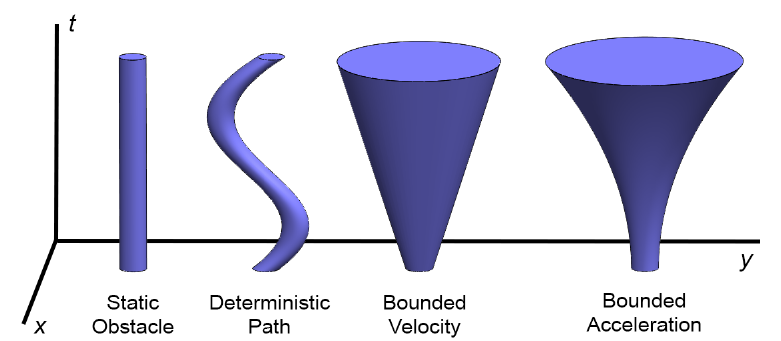
Figure 4. Obstacles as space-time volumes in (cid:60) 2 × Time space, adapted from [235]. Time is shown in vertical axis. When accounting for uncertainty, obstacle size grows with respect to